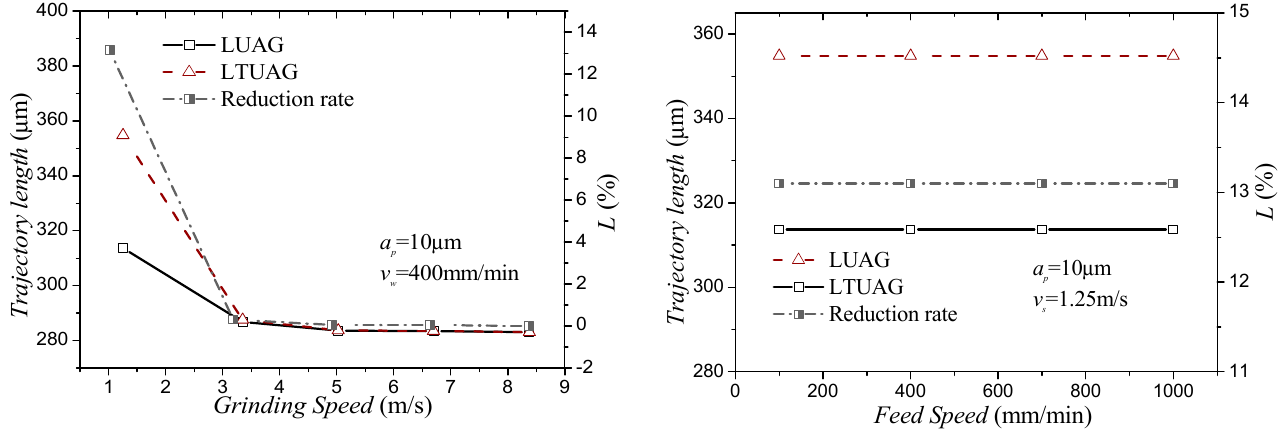
Figure 13. The trajectory length of LTUAG and LUAG.